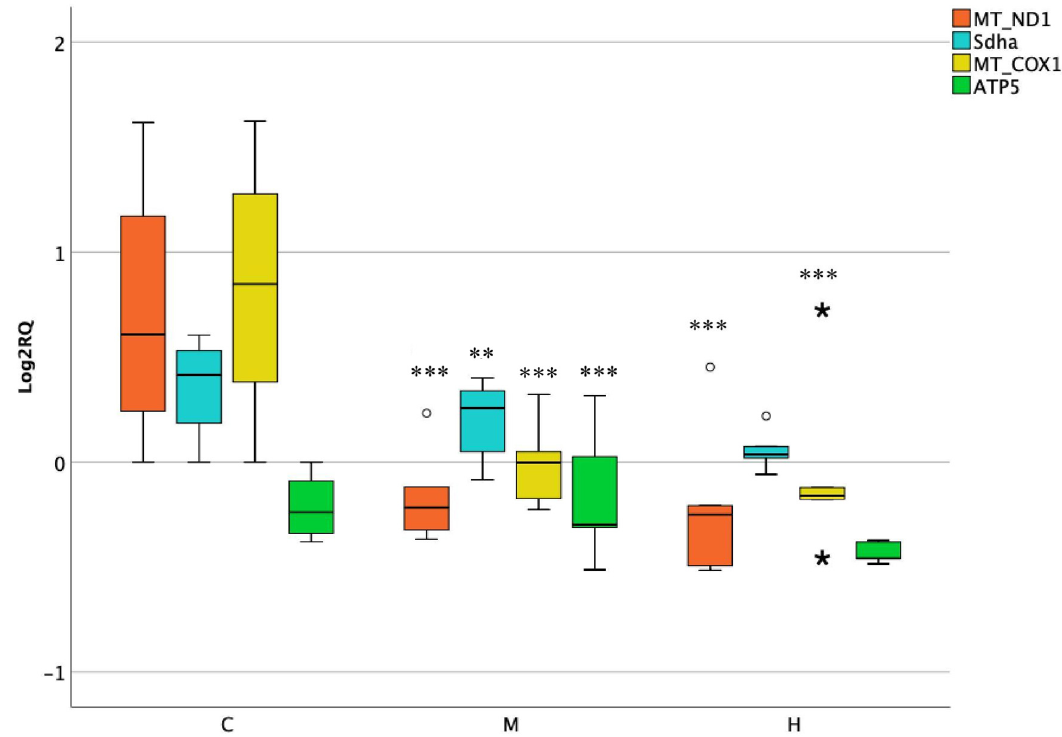
Figure 2. Box plot showing relative expression of mitochondrial and nuclear encoded genes in liver when compared to control C1 (Log2RQ = 0) to medium treatment (M) and high treatment (H) by qPCR. RQ, relative quantification. The box plots show the median value (horizontal line), the top and bottom edges of the boxes (75% and 25% percentiles), ( ★ ) extreme cases, (o) outliers (atypical values) and whiskers, which are the furthest values away from the boxes that are not considered outliers. ** p < 0.01; *** p < 0.001 significantly different from the control.